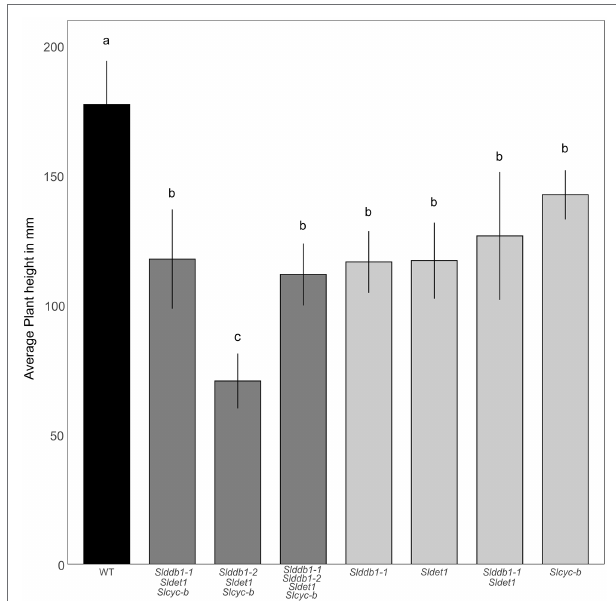
FIGURE 4 | Plant development in segregating T 3 and BC 1 F 3 generations. Plant size was measured with 3-month-old plants from the cotyledon to the top of the plant canopy. Black indicates WT, dark gray indicates T 3 triple mutant lines, and light gray indicates BC 1 F 3 segregants. Error bars indicate SD, and letters and upper bars indicate groups significantly different at p = 0.05 according to the SNK test.